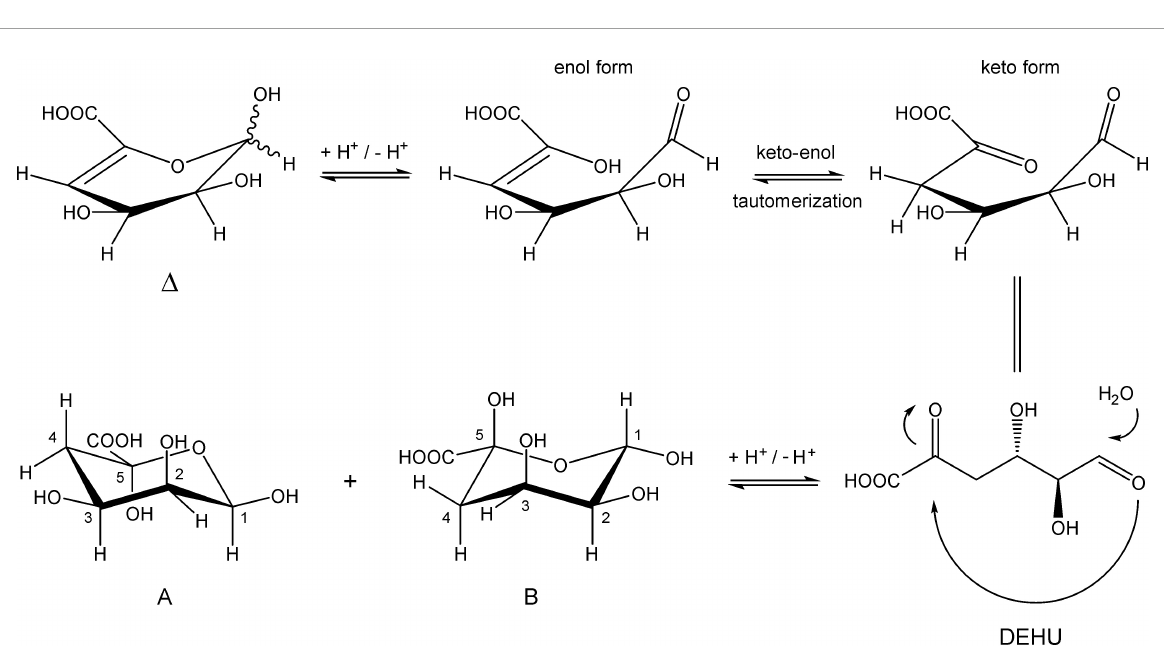
remains unclear how these products are generated and further study is in